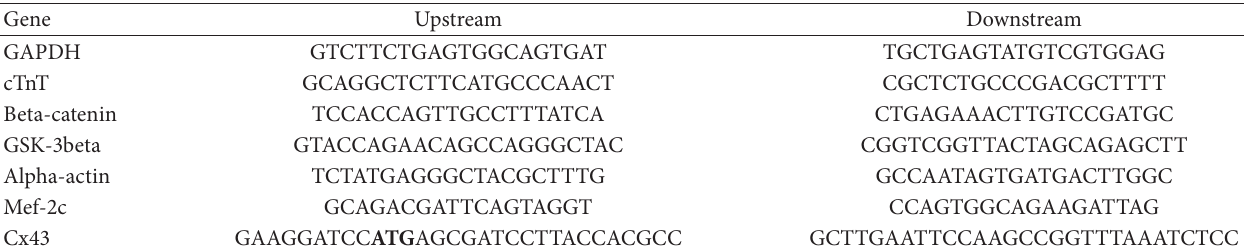
Table 1: Primers for real-time quantitative